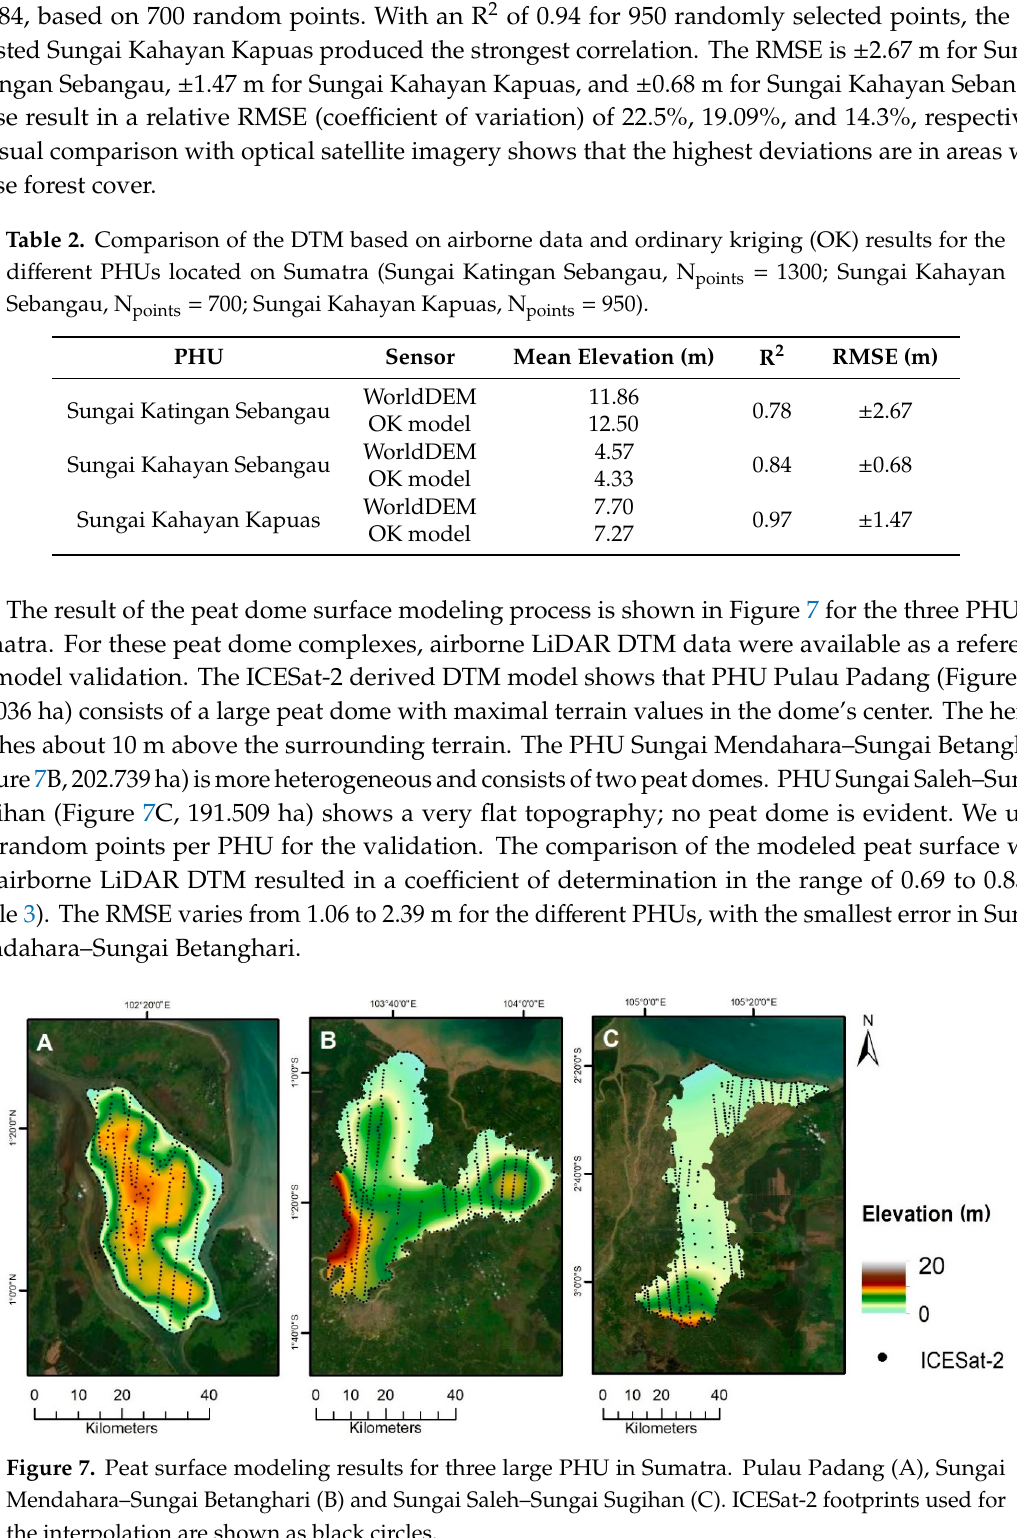
Table 2. Comparison of the DTM based on airborne data and ordinary kriging (OK) results for the